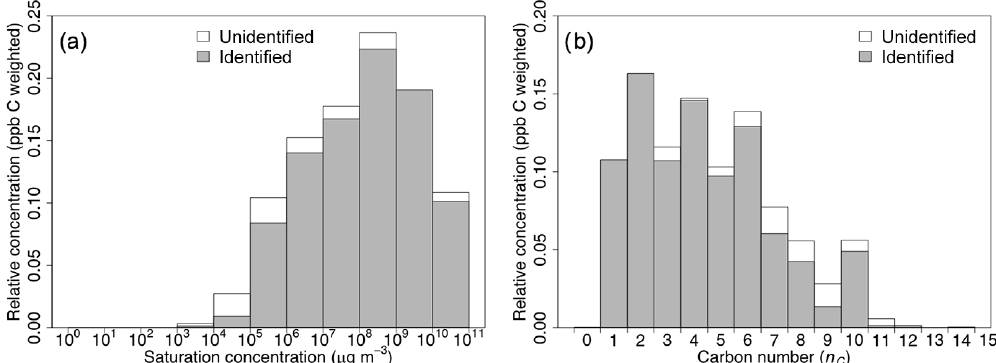
Figure 5. Estimated saturation vapor concentration distribution (a) and carbon number ( n C ) distribution (b) for compounds (NMOGs) measured by the PTR-ToF-MS (Koss et al., 2018) in the chamber prior to oxidation, averaged over all burns. Distributions are separated into identified and unidentified ions and are weighted by parts-per-billion carbon (ppbC).